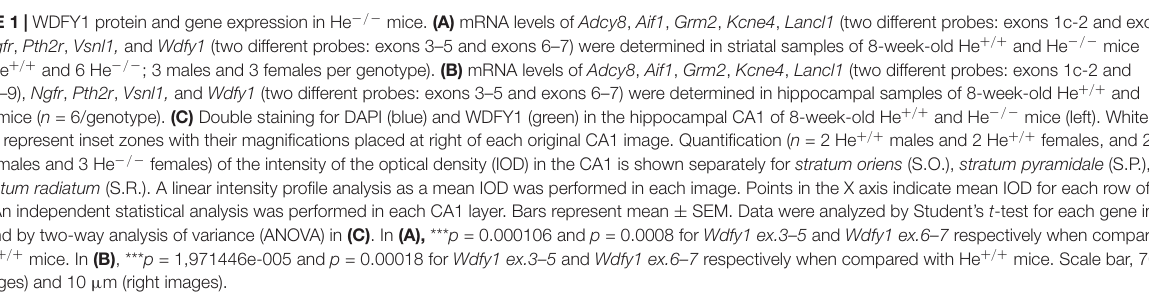
FIGURE 1 | WDFY1 protein and gene expression in He − / − mice. (A) mRNA levels of Adcy8 , Aif1 , Grm2 , Kcne4 , Lancl1 (two different probes: exons 1c-2 and exons 7–9), Ngfr , Pth2r , Vsnl1, and Wdfy1 (two different probes: exons 3–5 and exons 6–7) were determined in striatal samples of 8-week-old He + / + and He − / − mice ( n = 6 He + / + and 6 He − / − ; 3 males and 3 females per genotype). (B) mRNA levels of Adcy8 , Aif1 , Grm2 , Kcne4 , Lancl1 (two different probes: exons 1c-2 and exons 7–9), Ngfr , Pth2r , Vsnl1, and Wdfy1 (two different probes: exons 3–5 and exons 6–7) were determined in hippocampal samples of 8-week-old He + / + and He − / − mice ( n = 6/genotype). (C) Double staining for DAPI (blue) and WDFY1 (green) in the hippocampal CA1 of 8-week-old He + / + and He − / − mice (left). White squares represent inset zones with their magnifications placed at right of each original CA1 image. Quantification ( n = 2 He + / + males and 2 He + / + females, and 2 He − / − males and 3 He − / − females) of the intensity of the optical density (IOD) in the CA1 is shown separately for stratum oriens (S.O.), stratum pyramidale (S.P.), and stratum radiatum (S.R.). A linear intensity profile analysis as a mean IOD was performed in each image. Points in the X axis indicate mean IOD for each row of pixels. An independent statistical analysis was performed in each CA1 layer. Bars represent mean ± SEM. Data were analyzed by Student’s t -test for each gene in (A,B) and by two-way analysis of variance (ANOVA) in (C) . In (A), *** p = 0.000106 and p = 0.0008 for Wdfy1 ex.3–5 and Wdfy1 ex.6–7 respectively when compared with He + / + mice. In (B) , *** p = 1,971446e-005 and p = 0.00018 for Wdfy1 ex.3–5 and Wdfy1 ex.6–7 respectively when compared with He + / + mice. Scale bar, 70 (left images) and 10 µ m (right